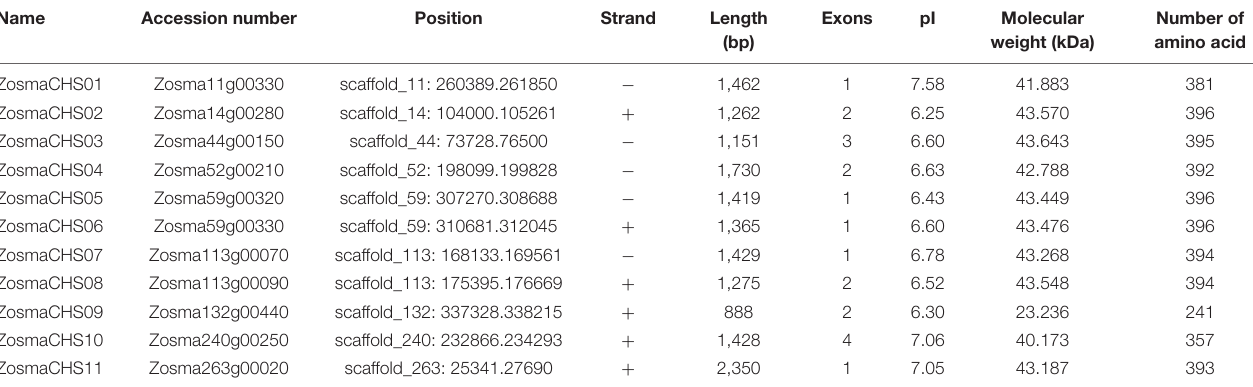
TABLE 1 | Members and characterizations of ZosmaCHS